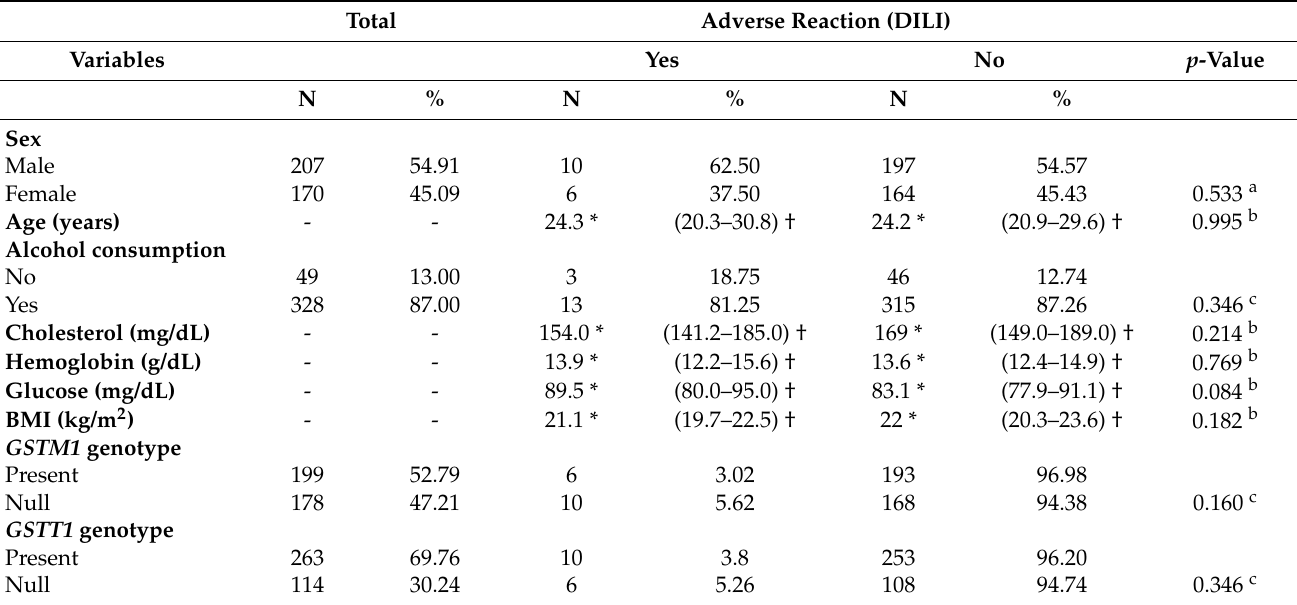
Table 1. Clinical and biological variables of adult patients diagnosed with sensitive pulmonary